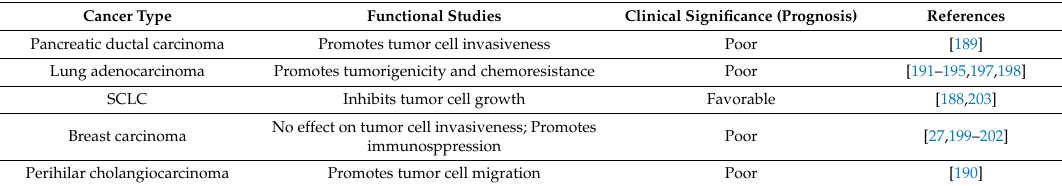
Table 2. Role of podoplanin-expressing cancer-associated fibroblasts (CAFs) in tumor progression. Correlation between functional studies and clinical